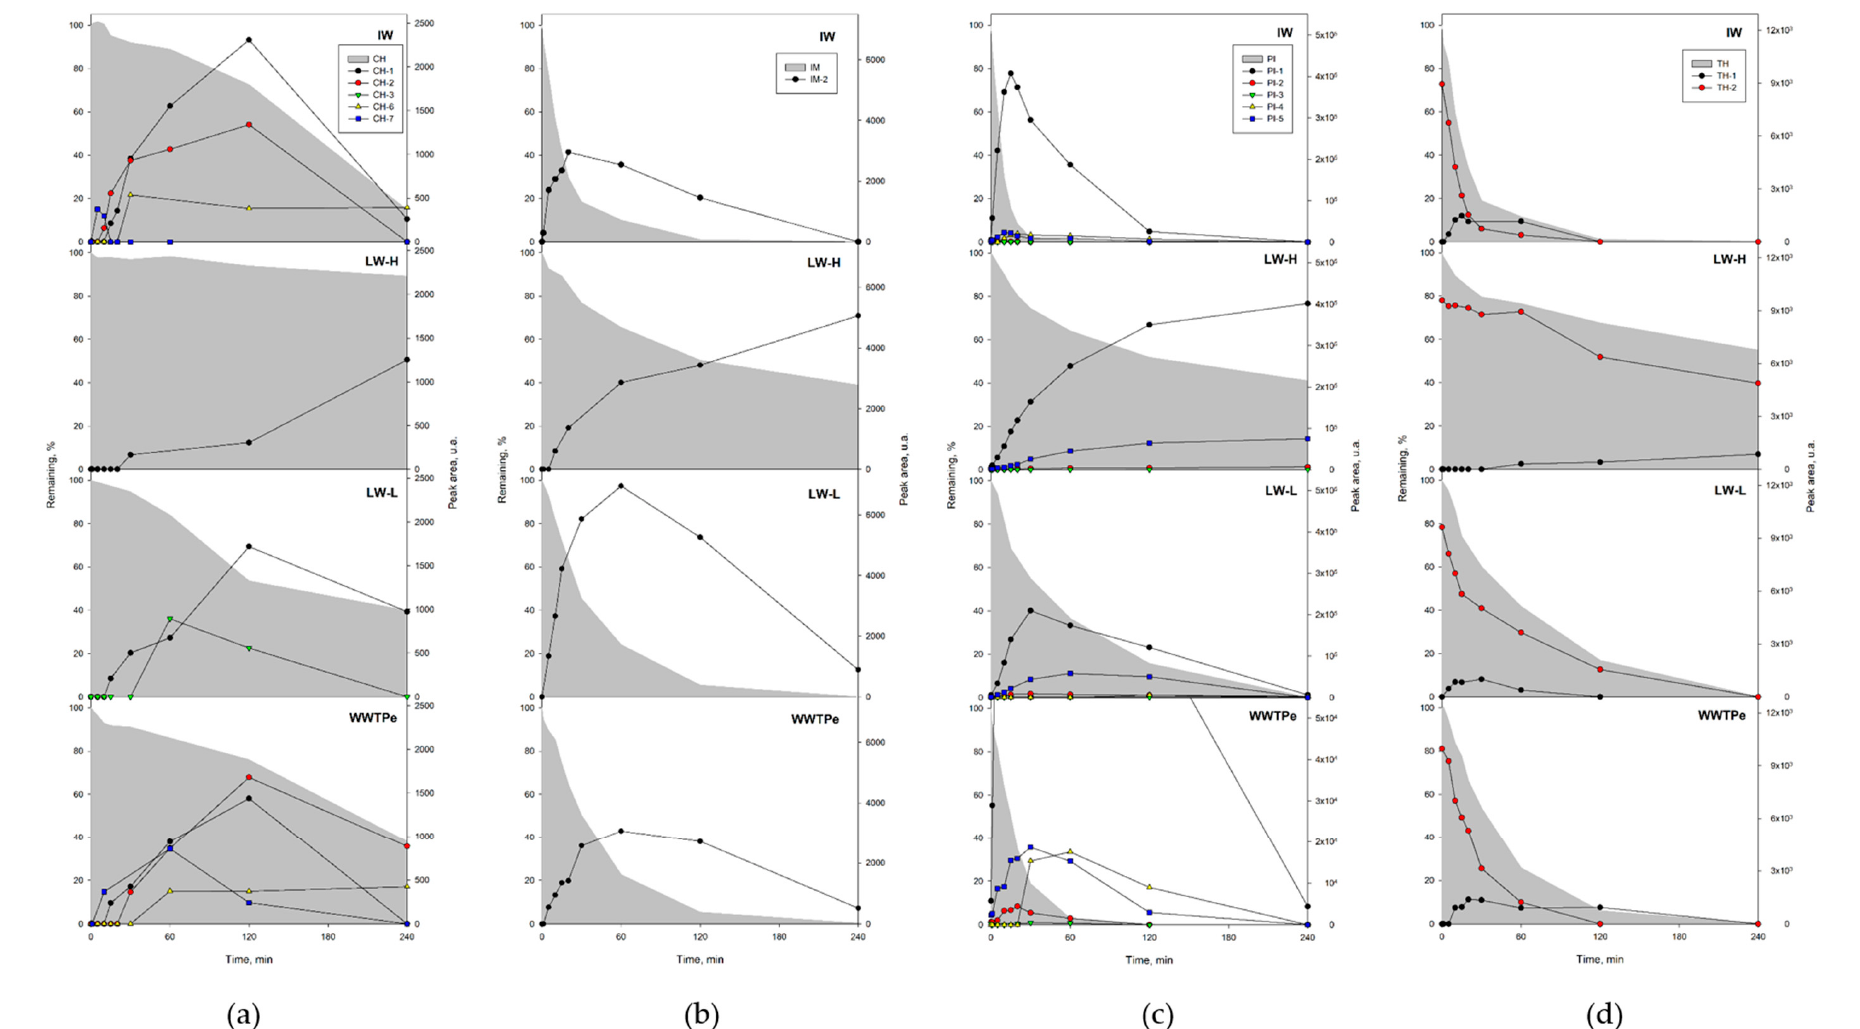
Figure 2. Degradation kinetics of ( a ) chlorantraniliprole; ( b ) imidacloprid; ( c ) pirimicarb; ( d ) thiamethoxam, spiked at 1 mg L − 1 , and their TPs (peak area data) during the UVA-LED photocatalytic process, in the studied water matrices.